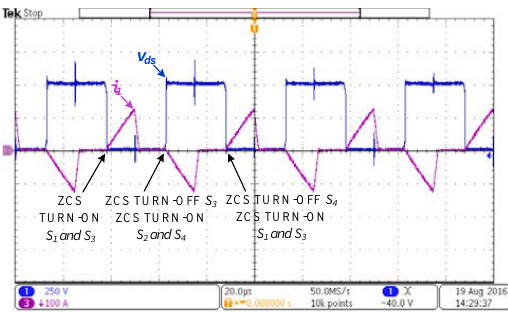
Figure 20. Drain-to-source voltage, v DS , of SiC power MOSFET ( S 3 ) and line current, i 1 , waveforms in